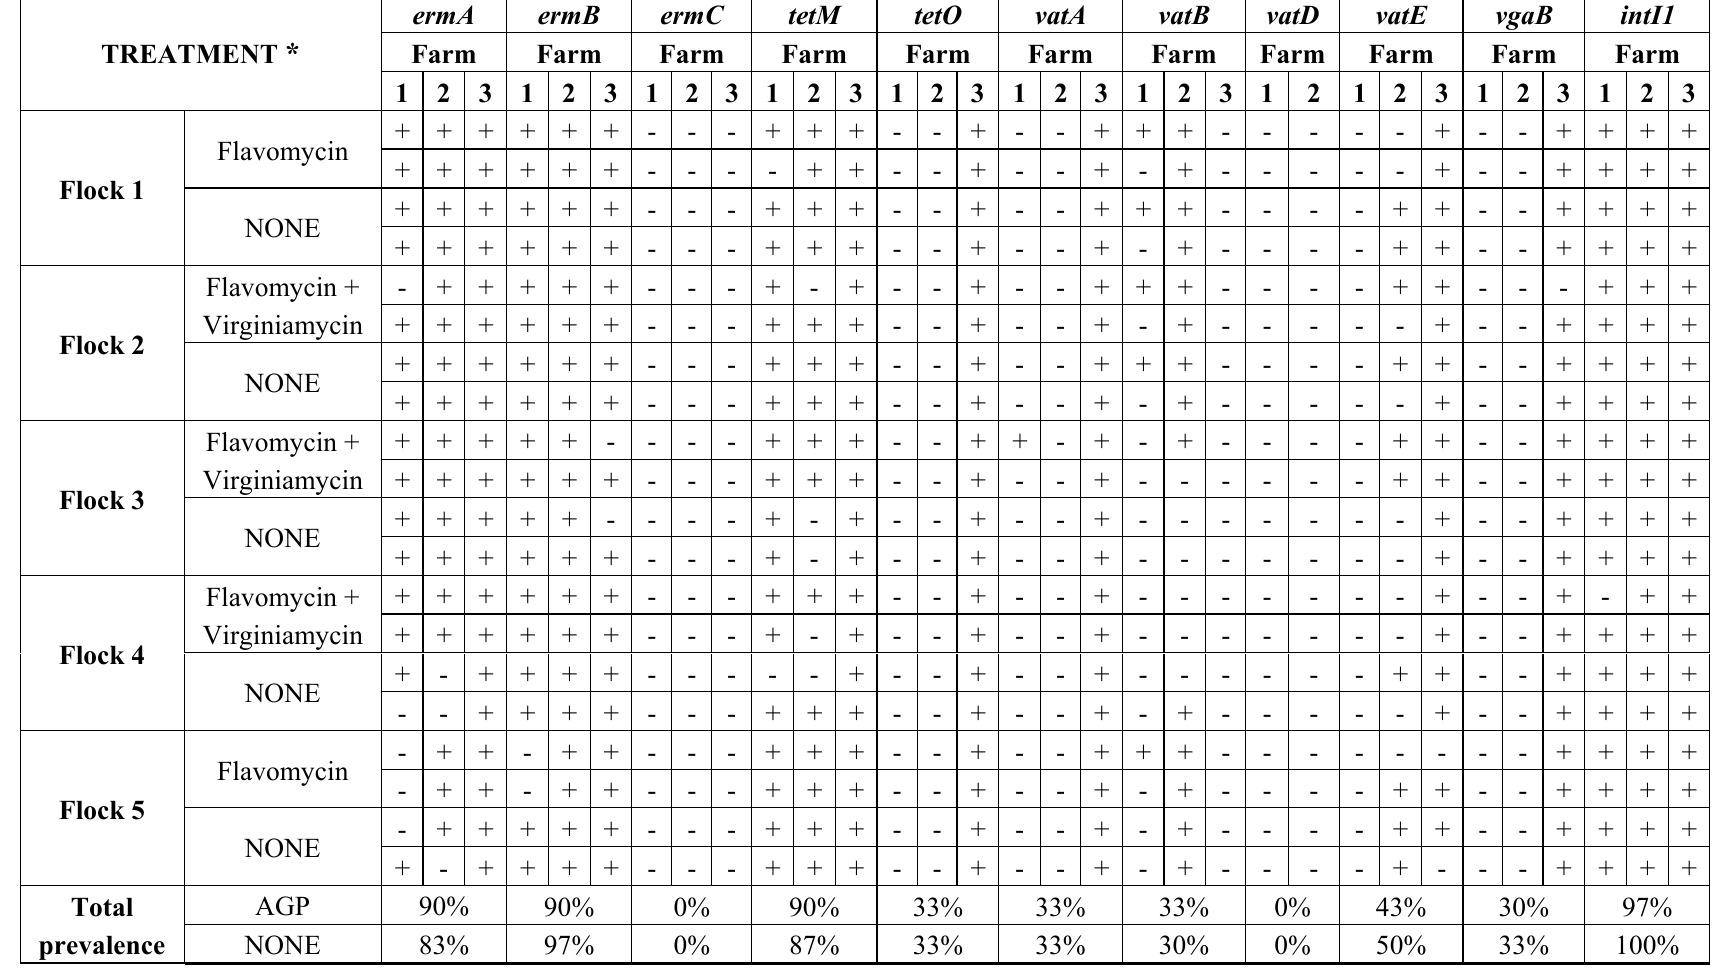
Table 5. Prevalence of resistance genes in litter obtained from 5 sequential flocks of broiler chickens raised on 3 commercial poultry farms. Two houses on each farm received no antibiotics; two houses received flavomycin or flavomycin + virginiamycin